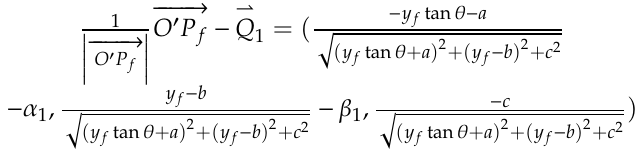
Figure 3. The schematic diagram of incident ray and reflecting ray at the vertex of curved surface. The vector along the bisector of the angle